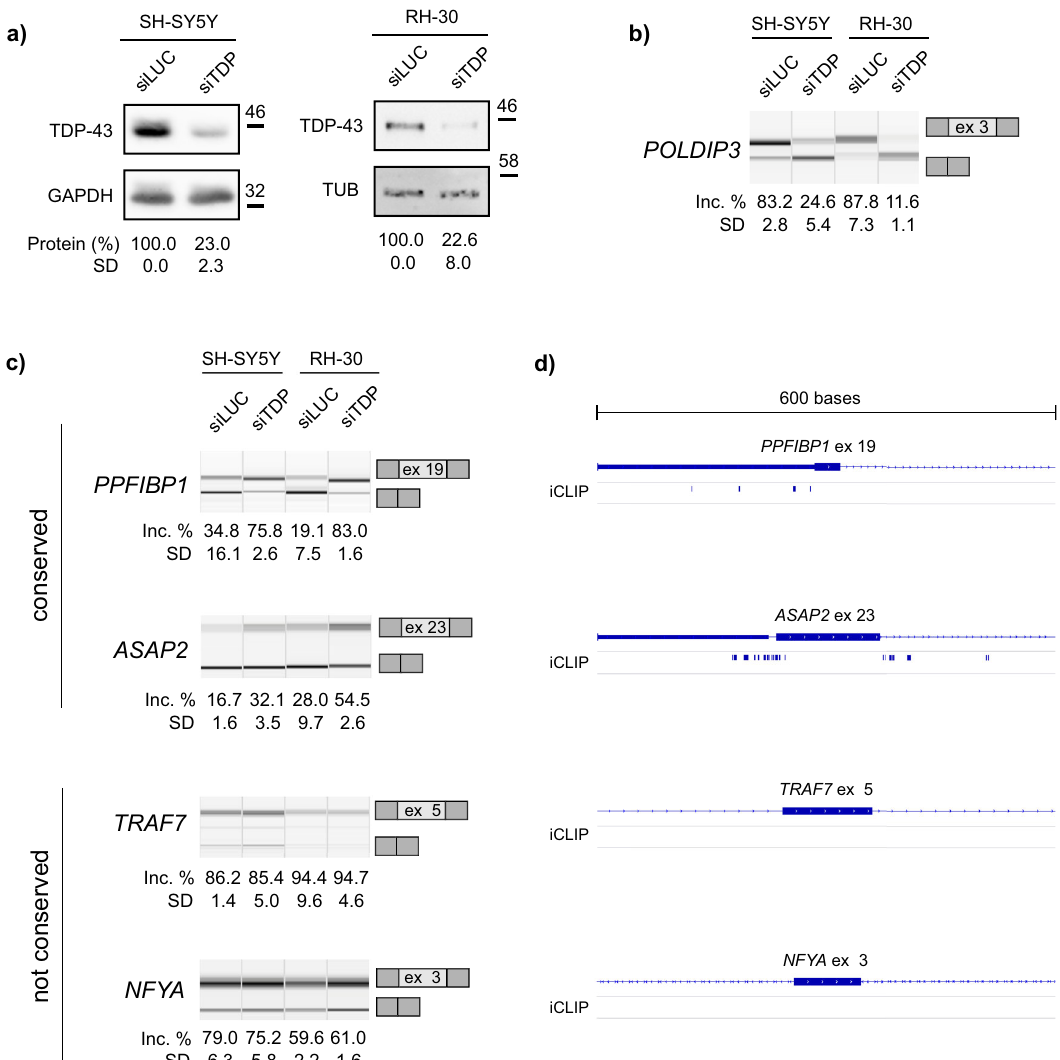
Fig. 8 Alternative exons regulated by TDP-43 in mouse are subject to TDP-43 regulation in human cell lines or not. a Western blot shows ef fi cient reduction of TDP-43 in SH-SY5Y and RH-30 cells upon siTDP transfection. The amount of TDP-43 was normalized against GAPDH or tubulin ( n = 3 replicates per group). b TDP-43 depletion led to altered splicing of POLDIP3 . Semi-quantitative RT-PCR conducted in TDP-43-silenced samples and corresponding controls is shown along with the quanti fi cation of splicing changes (% of alternative exon inclusion). The number of the alternative exon is given below ( n = 3 replicates per group). c Alternatively spliced exons regulated by TDP-43 in mouse cells are either subject to TDP-43 regulation in human cells ( PPFIBP1 exon 19 and ASAP2 exon 23) or not ( TRAF7 exon 5 and NFYA exon 3). Semi-quantitative RT-PCRs conducted in TDP-43-silenced samples and corresponding controls are shown along with the quanti fi cation of splicing changes (% of alternative exon inclusion). Number of the alternative exon is given in the scheme (see the exact transcript numbers in Supplementary Table 2, n = 3 replicates per group). d